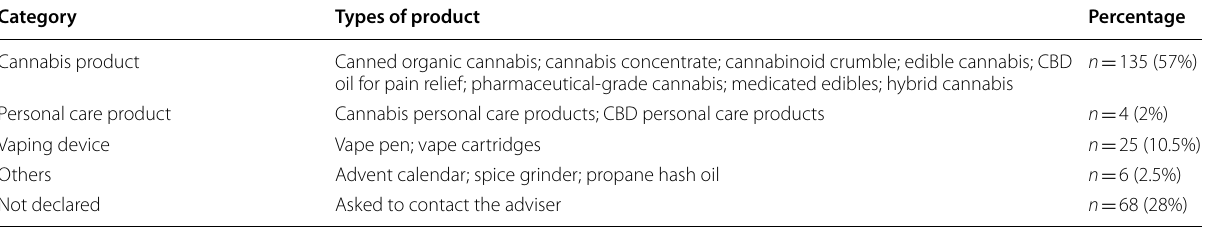
Table 4 Giveaways from the unlicensed retailers